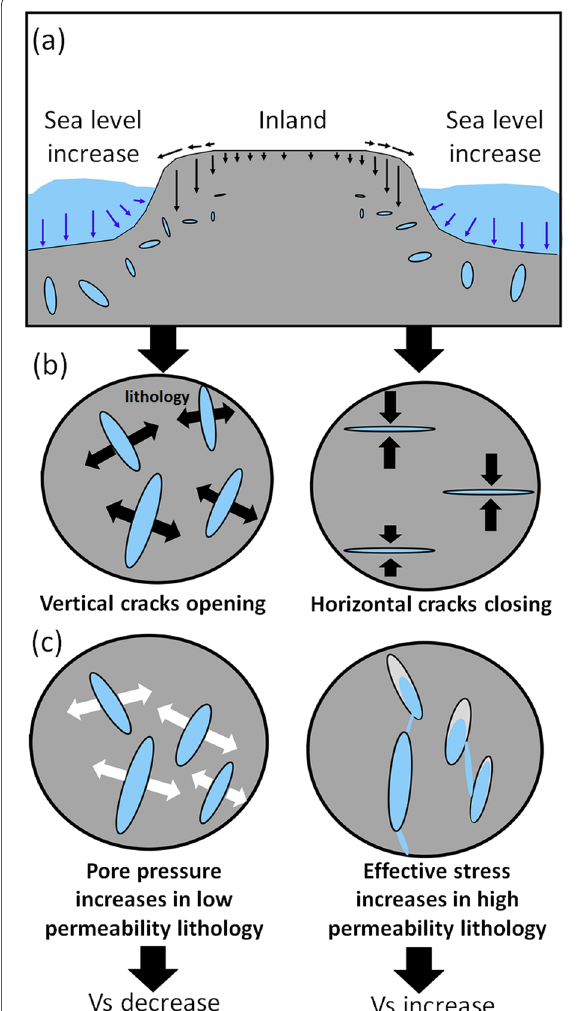
Fig. 10 a Schematic diagram illustrating the inland surface displacement associated with ocean loading and inferred effects on seismic velocity. Increasing sea water mass exerts a load on the seafloor and the nearby coast (blue arrows), resulting in vertical and horizontal displacements of the land (black arrows). The dominant vertical displacement causes compression in the subsurface that can result in possible outcomes: b change of cracks (marked by the black arrow) and c change of pore pressure conditions (pore pressure increase is marked by the white arrow) that affect the response of seismic velocity to ocean